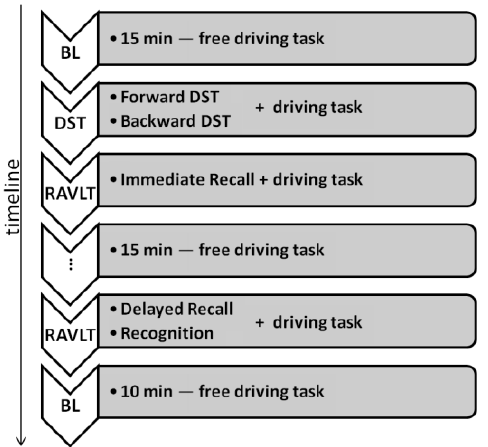
Figure 2. Pipeline of the experimental protocol.